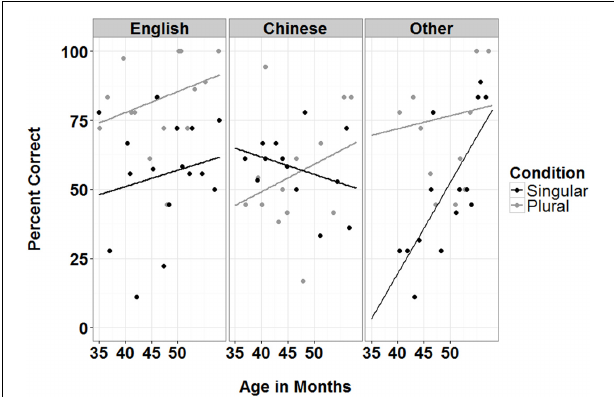
FIGURE 7 | Percent correct on singular and plural items as a function of Age (months) for three L1 groups (English, Chinese, and other languages).